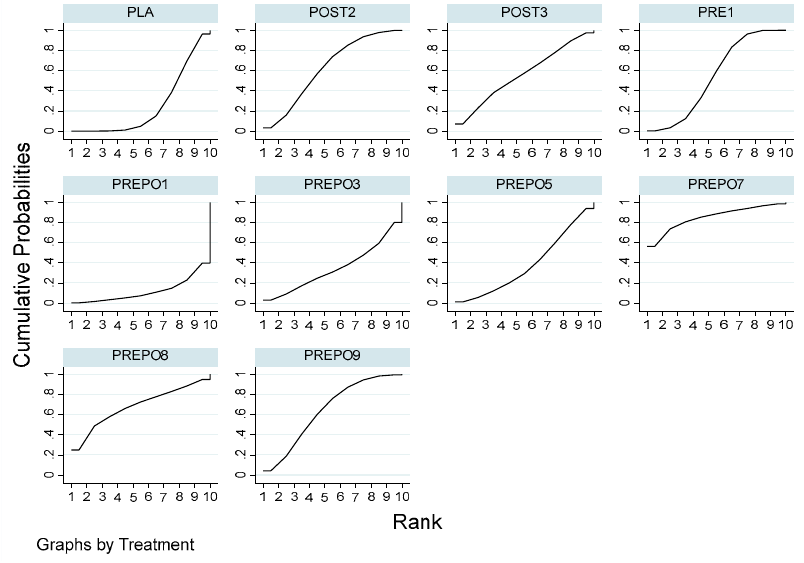
Figure 7. SUCRA ranking curve for implant failure (per implant).